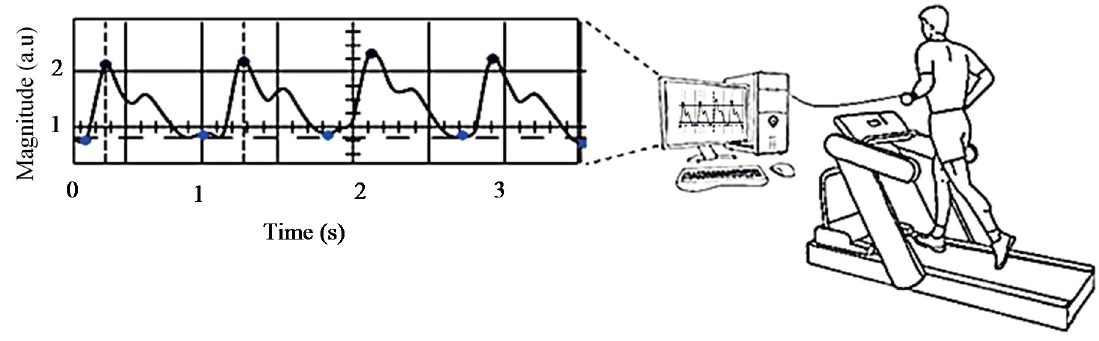
Figure 10. Physiological testing setup and platform, left is the LabView GUI and right is the